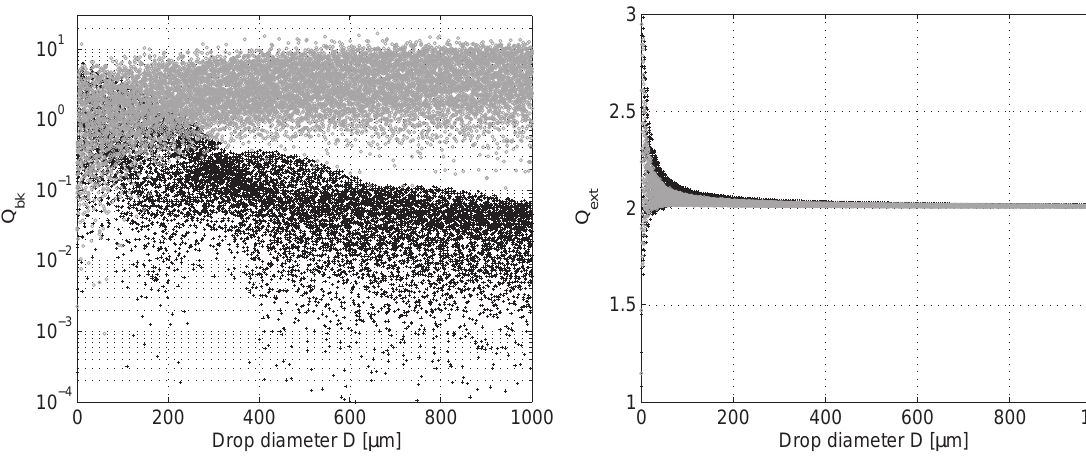
Fig. 1. Backscatter and extinction efficiencies for spherical water drops, sampled at 0.1µm intervals. Grey points are for λ = 905nm, black points are for λ =1.5µm.